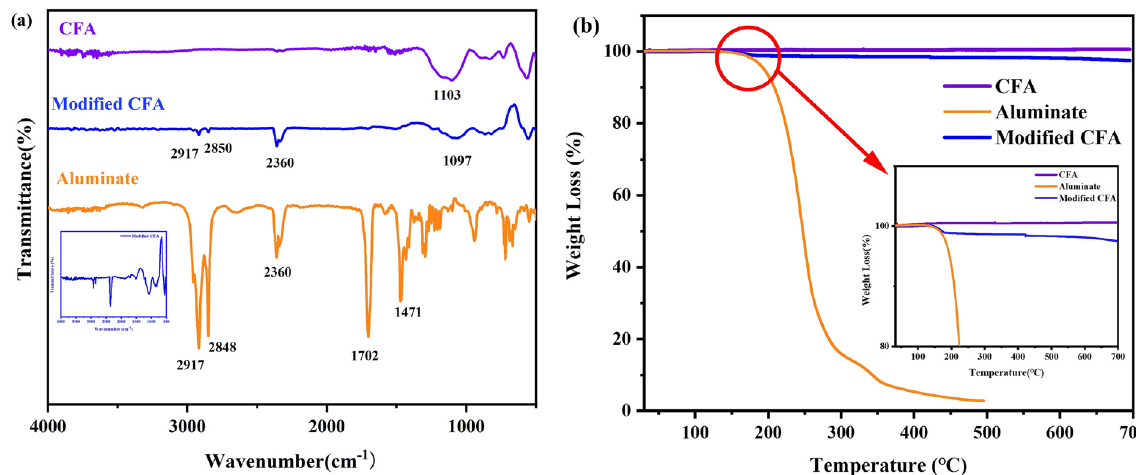
Figure 4: ( a ) FTIR spectra of CFA, modi fi ed CFA, and aluminate. ( b ) TGA pro fi les of CFA, modi fi ed CFA, and aluminate.